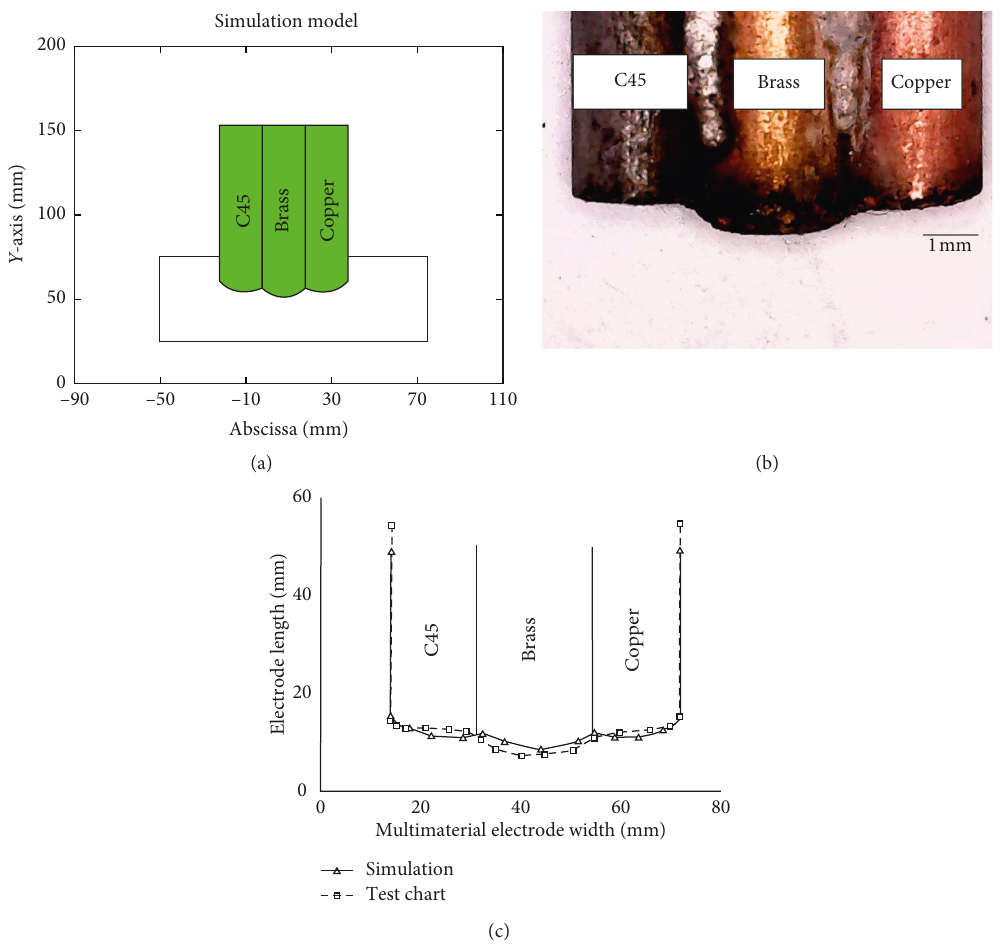
Figure 10: Comparison of the simulation and experimental results of copper-brass-C45 multimaterial electrodes. (a) C45-brass-copper simulation results. (b) C45-brass-copper experimental results. (c) Simulation extraction curve and experimental identification